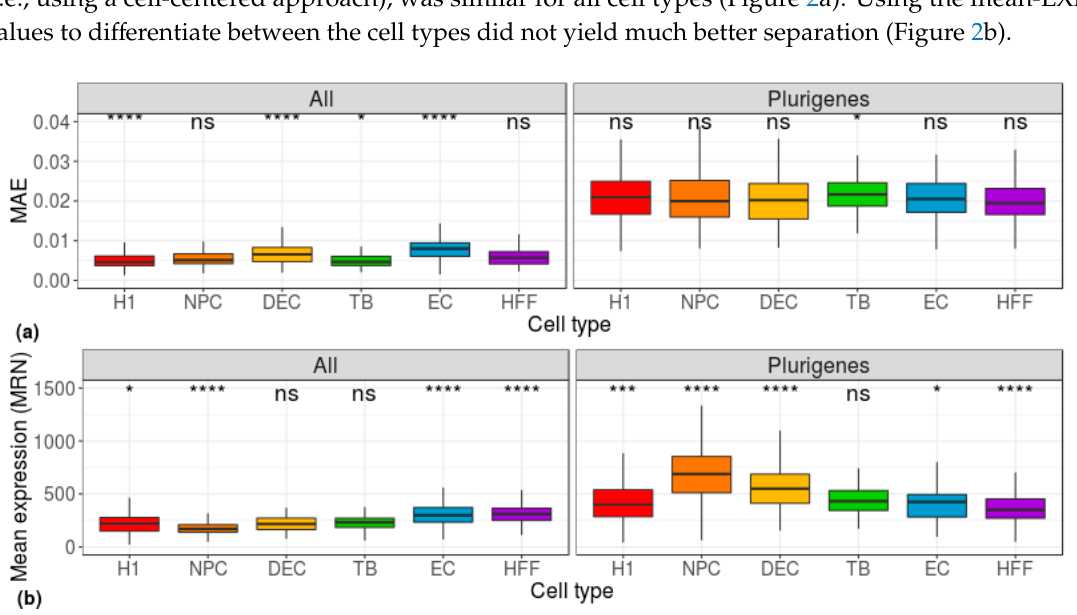
Figure 2. Distribution of group-based, cell-centered ( a ) MAE and ( b ) mean-expression scores, calculated across all genes (left) and across 178 pluripotent genes (right) [26]. H1: human embryonic stem cells ( n = 375 cells); NPC: neural progenitor cells ( n = 173 cells); DEP: definitive endoderm progenitors ( n = 138 cells); EC: endothelial cells (n = 105 cells); TB: trophoblasts ( n = 69 cells); HFF: human foreskin fibroblasts ( n = 159 cells). Each group was compared to all other cell types, combined, using a Wilcoxon test. Ns: non-significant ( p > 0.05), * p ≤ 0.05, ** p ≤ 0.01, *** p ≤ 0.001, **** p ≤ 0.0001.